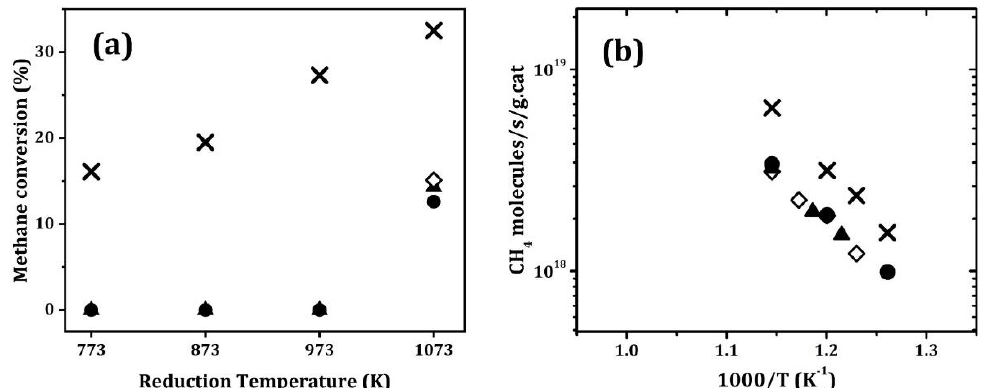
Figure 5. Oxidation isotherm obtained using coulometric titration at 1073 K for ( × ) Ni / MgAl 2 O 4 ; ( ▲ ) Ni / CaTiO 3 / MgAl 2 O 4 ; ( ♦ ) Ni / SrTiO 3 / MgAl 2 O 4 ; and, ( • ) Ni / BaTiO 3 / MgAl 2 O 4 .